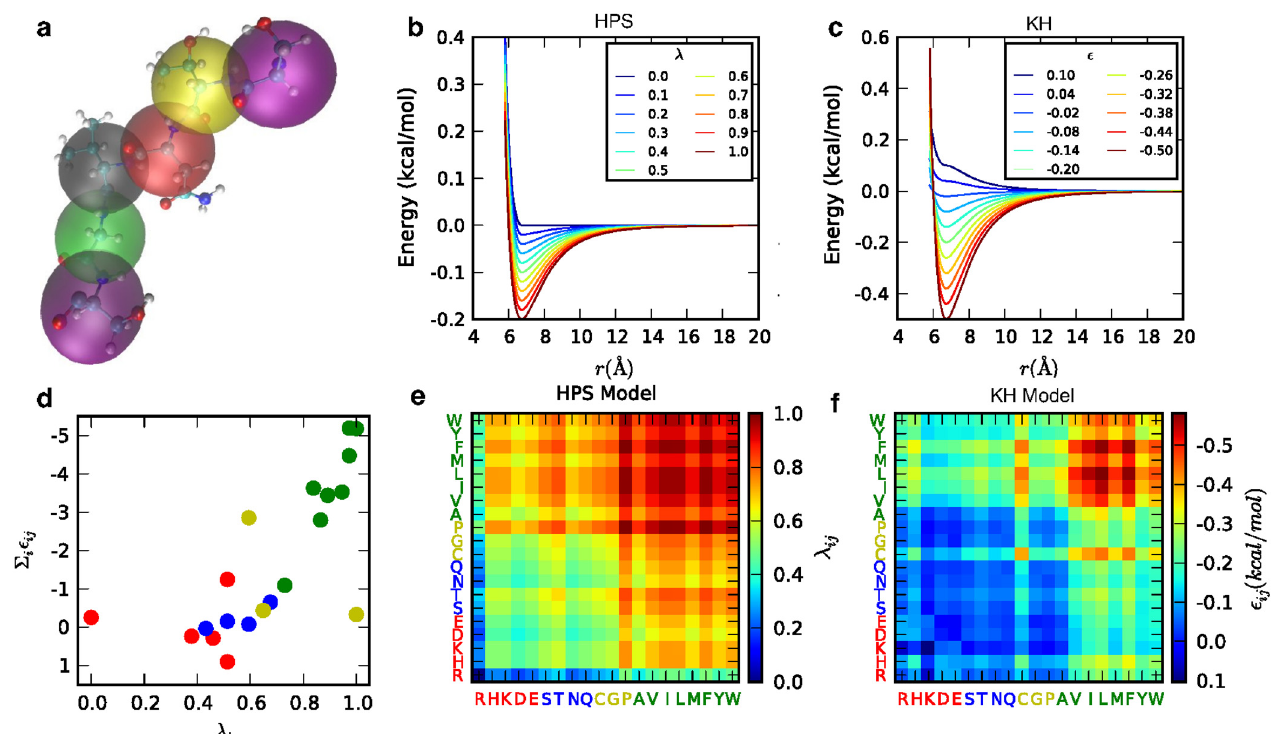
Fig 1. Schematic of the two knowledge-based potentials used for short-range pairwise interactions. a) Each amino acid is treated as a single particle. b, c) Potential energy functional form for HPS and KH models at different interaction strengths, plotted with a constant σ value of 6 Å . d) Correlation between the amino acid interaction strength ( S (cid:15) ) in KH model and hydrophobicity ( λ ) in HPS model, colored by the side-chain properties of amino acids (i.e., red for i ij i charged, blue for polar, green for hydrophobic and yellow for other amino acids). e, f) The pairwise interaction parameters used in HPS and KH models shown in color maps with blue being most repulsive interactions and red being most